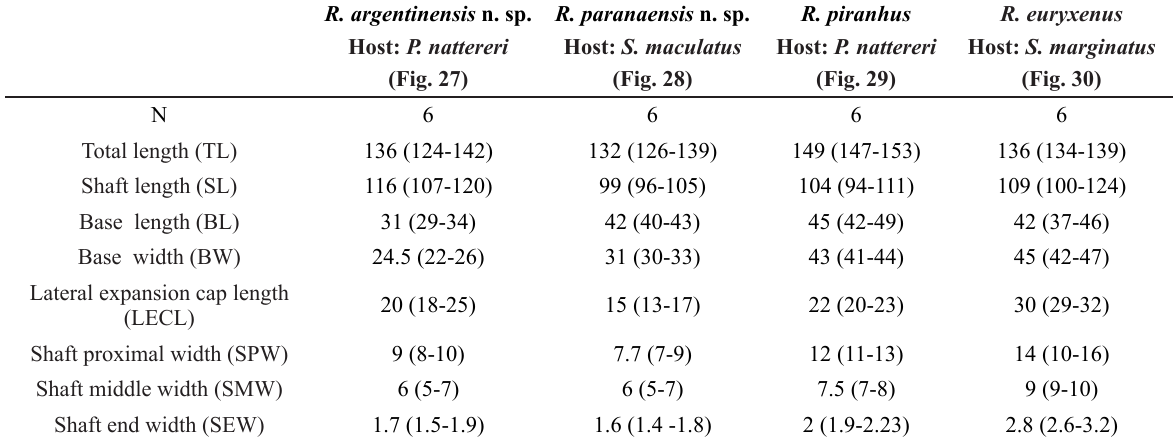
Comparative measurements (in µm) of ventral anchors of 4 Rhinoxenus species parasitizing piranhas . R. argentinensis n.